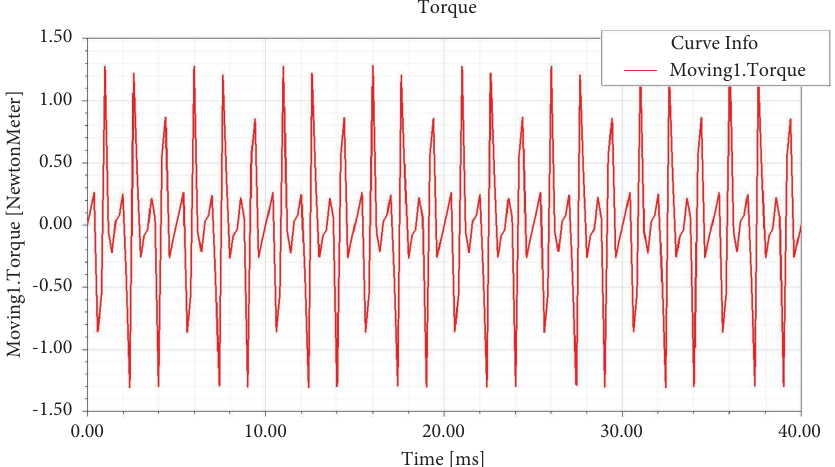
Moving1.TorqueCurve Info